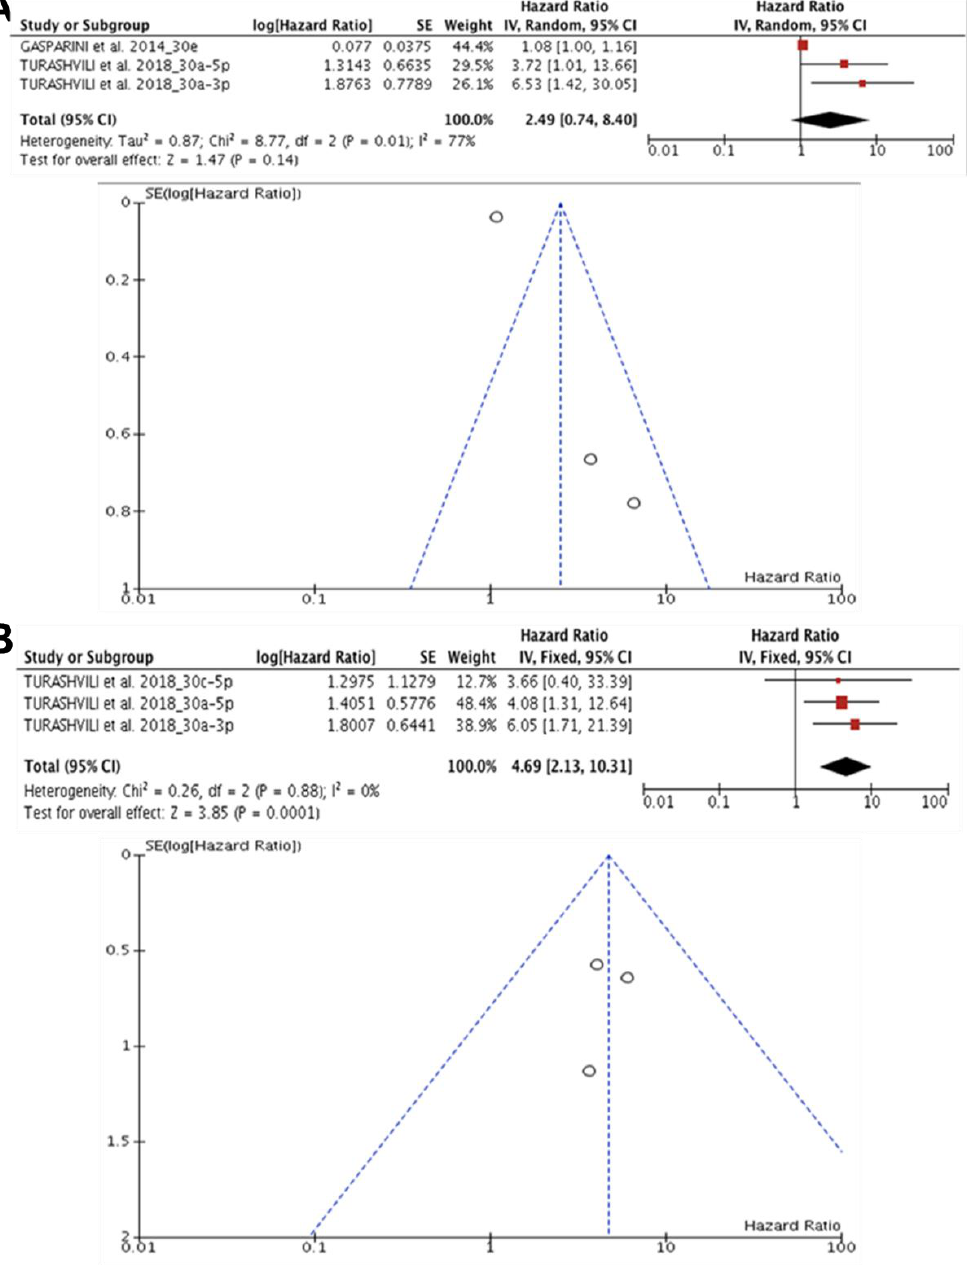
Figure 4. miR-30 and the prognosis in TNBC. ( A ) Forest and funnel plot related low miR-30 expression (30e, 30a-5p, 30a-3p, 30c-5p) is associated with poor prognosis in OS in patients with TNBC, (HR: 2.49, 95% CI: 0.79–8.40; I 2 = 77%, p = 0.01, Z = 1.47 ( p = 0.14) [42,62].( B ) Forest and funnel plot demonstrated that miR-30 expression significantly interfered with the RFS of patients with TNBC (HR: 4.69, 95% CI: 2.13-10.31; I2 = 0.0%, p = 0.88)), Z = 3.85, (p < 0.0001) [62].